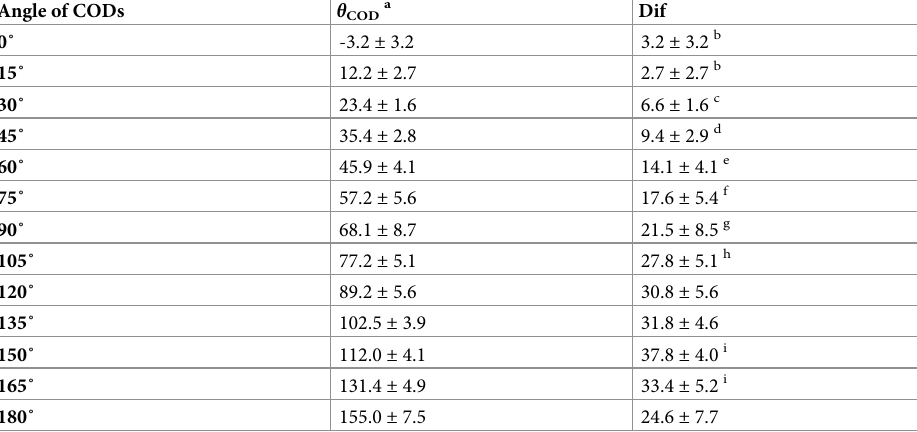
Table 1. Descriptive data on θ COD and the difference between each θ COD and set angle.